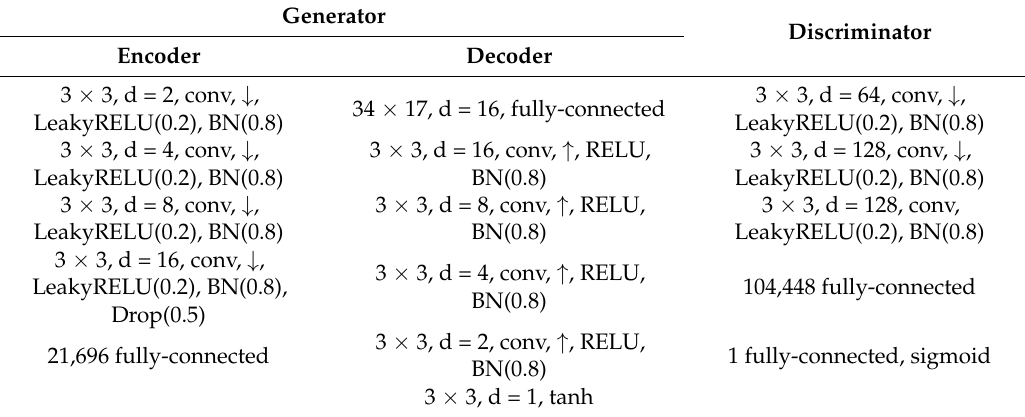
The architecture of the generative adversarial-based context encoder model on the Keras